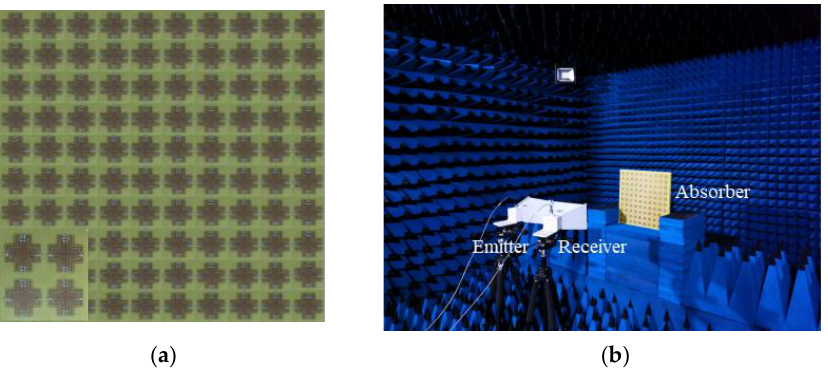
Figure 11. ( a ) Photograph of the fabricated sample; ( b ) photograph of the experimental environment.